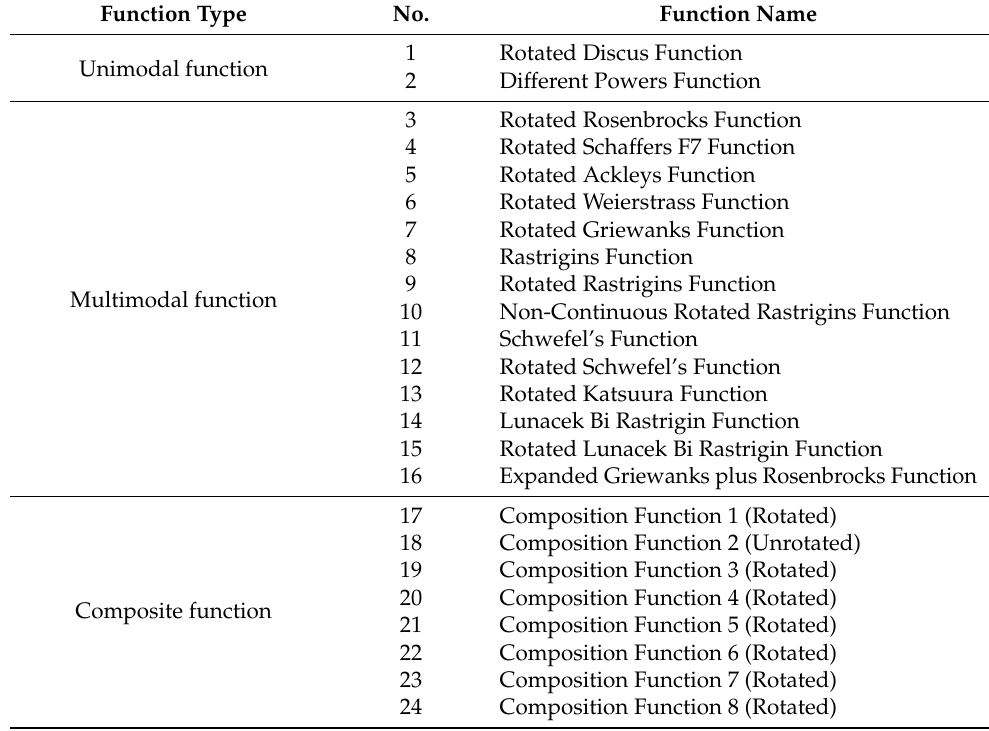
Table 1. The 24 test